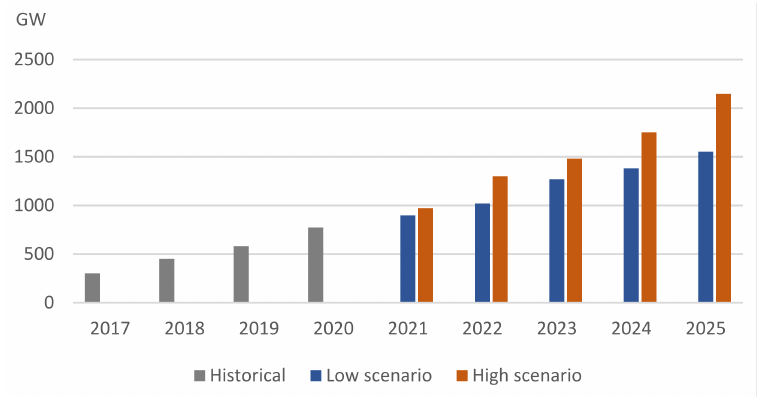
Figure 4. Forecasted increase in solar energy capacity. Source: Own study based on [30].